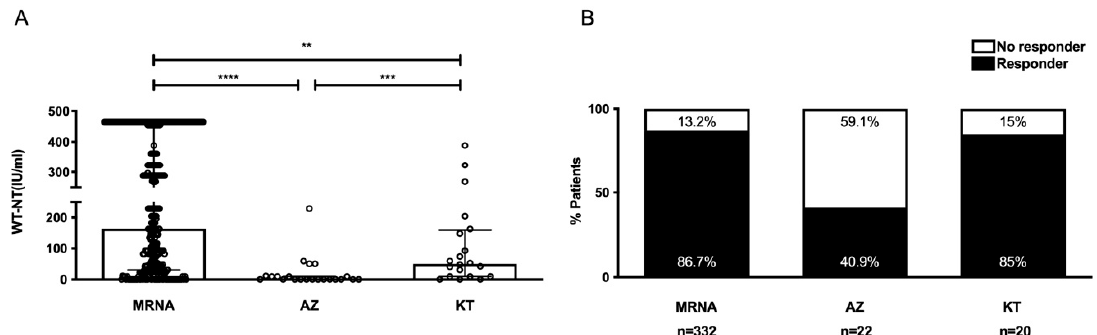
Figure 2. Comparison of the humoral responses (SARS-CoV-2 NT 50 antibodies) of the LT recipients after 2 vaccinations with the mRNA, vector and protein subunit vaccines. ( A ) SARS-CoV-2 NT 50 anti- bodies. Data are expressed as median and interquartile range. ** p < 0.01, *** p < 0.001, **** p < 0.0001 Table 3. Patient characteristics according to type of